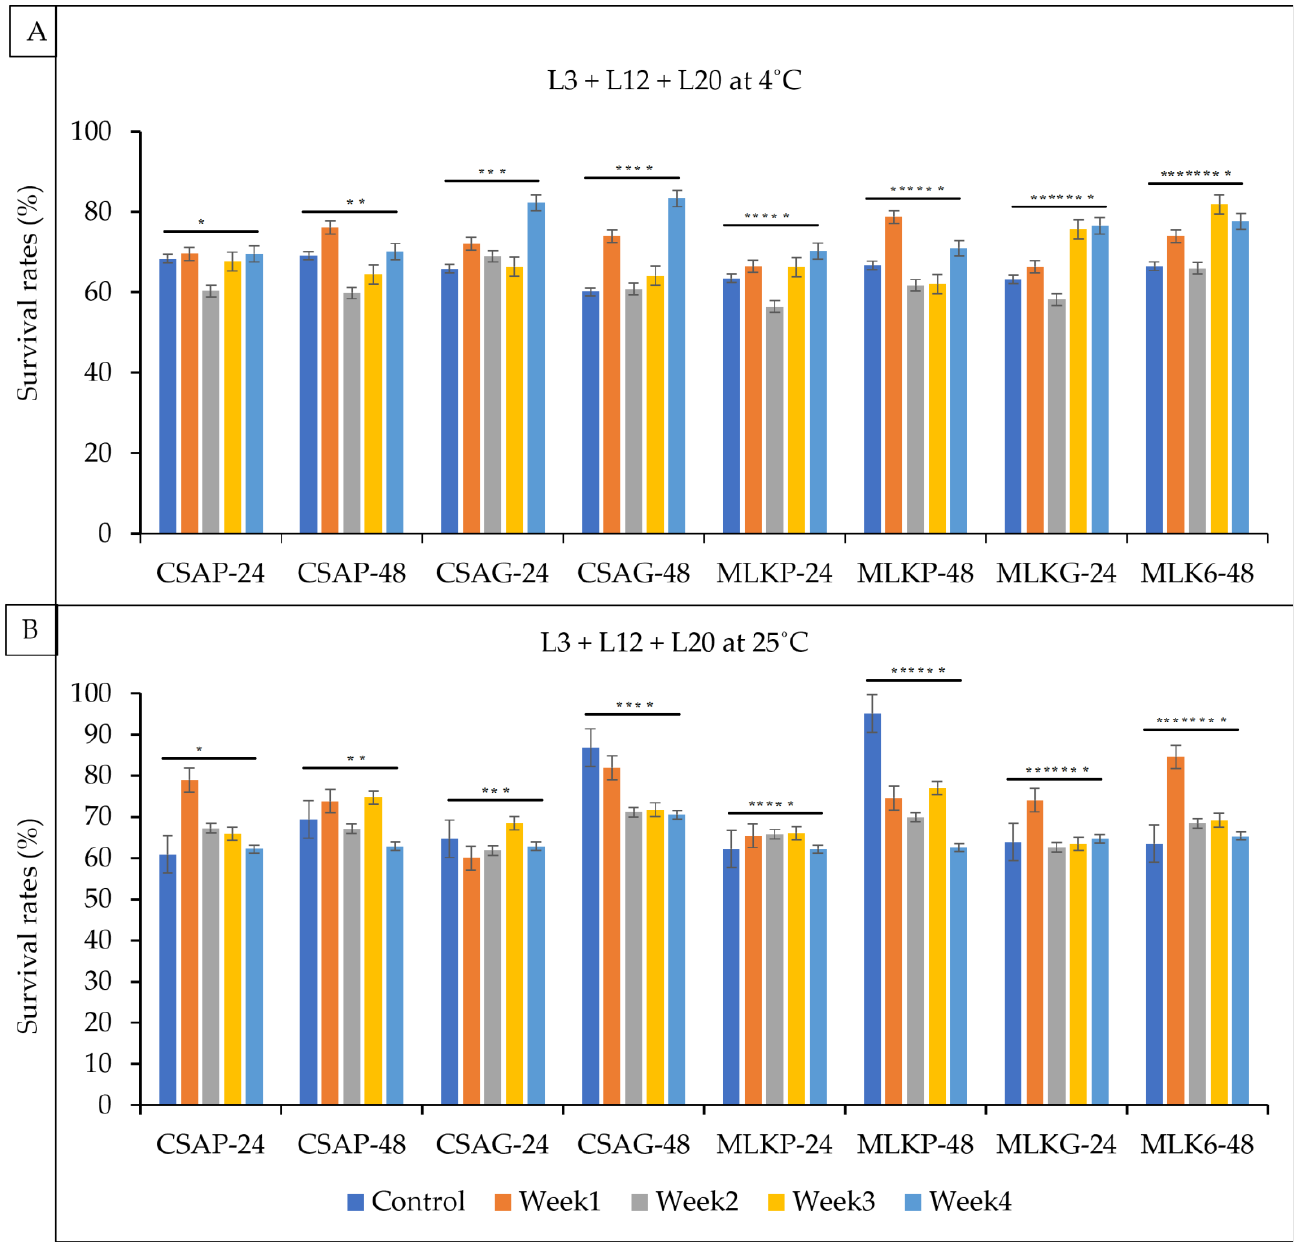
Figure 8. Viability of Lactococcus lactis (L3) + Lactobacillus delbrueckii (L12) + Leuconostoc mesenteroides (L20) following freeze-drying. ( A ) Survival rates at ambient temperature (25 °C), and ( B ) survival rates at refrigerated temperature (4 °C) for 24 h and 48 h. CSAP-24-Cassava in plastic at 24 h, CSAP-48-Cassava in plastic at 48 h, CSAG-24-Cassava in glass at 24 h, CSAG-48-Cassava in glass at 48 h, MLKp-24-Milk in plastic at 24 h, MLKP-48-Milk in plastic at 48 h, MLKG-24-Milk in glass at 24 h, MLKG-48-Milk in glass at 48 h. (Values represent means of three replicate experiments, ±: standard deviation). For ( A ) * p -value = 0.083647, ** p -value = 0.149906, *** p -value = 0.001165, **** p -value = 0.000686, ***** p -value = 0.290059, ****** p -value = 0.318028, ******* p -value = 0.020805, ******** p -value = 0.000277. For ( B ) * p -value = 0.000436, ** p -value = 0.459237, *** p -value = 0.439752, **** p -value = 0.000001, ***** p -value = 0.000397, ****** p -value = 0.000000, ******* p -value = 0.065586, ******** p -value = 0.000688.